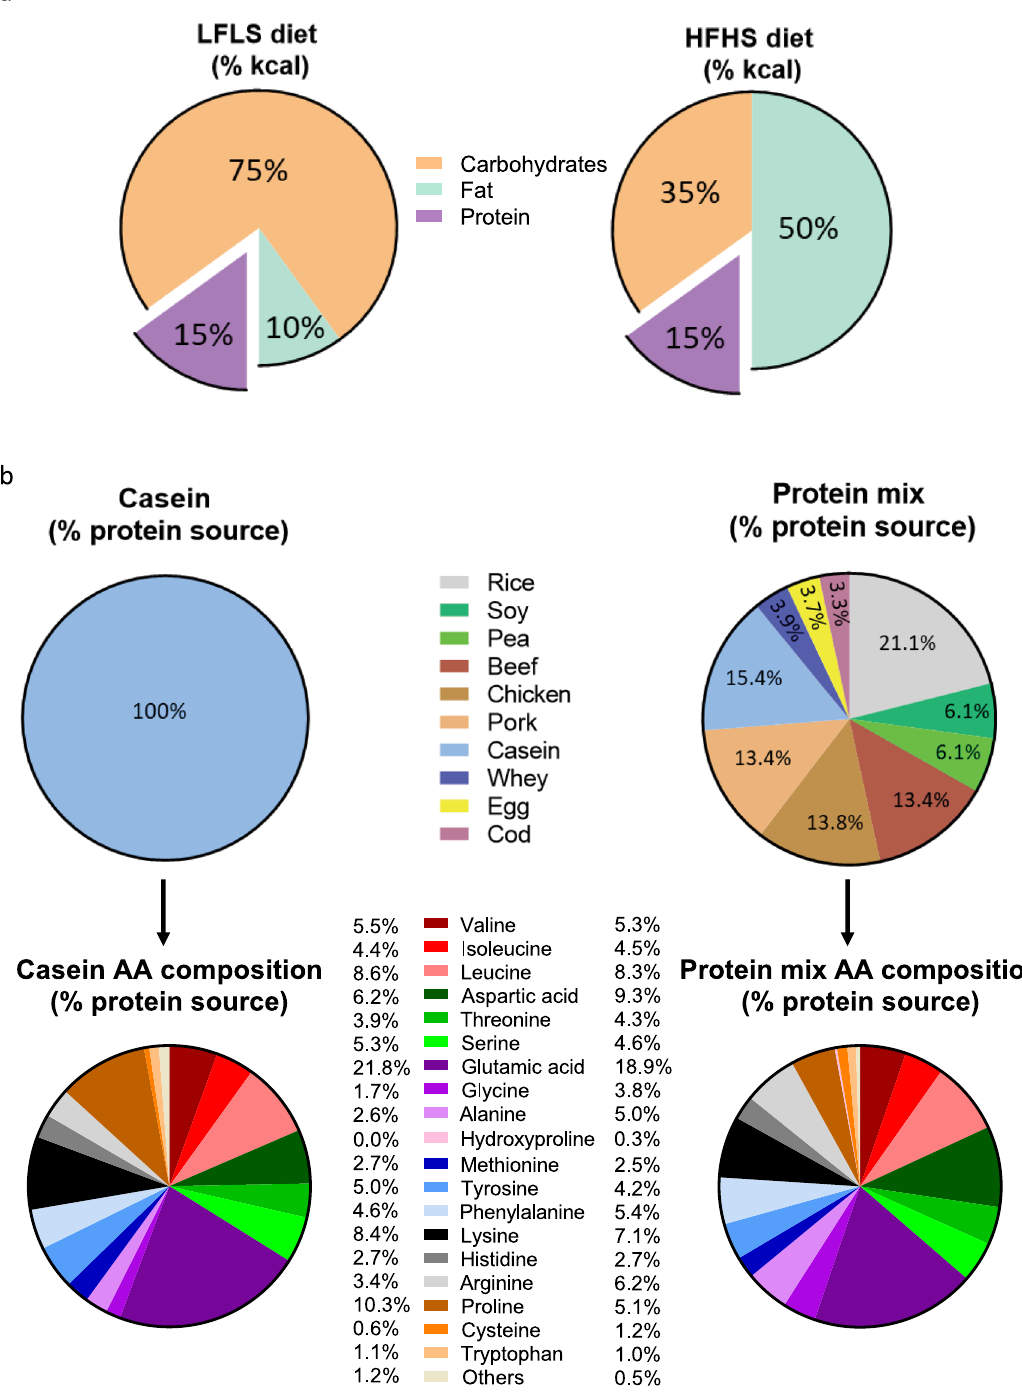
Fig. 1 A new protein mix was formulated to oppose casein use in rodent diets. a Macronutrient composition of LFLS (15% kcal proteins, 10% kcal